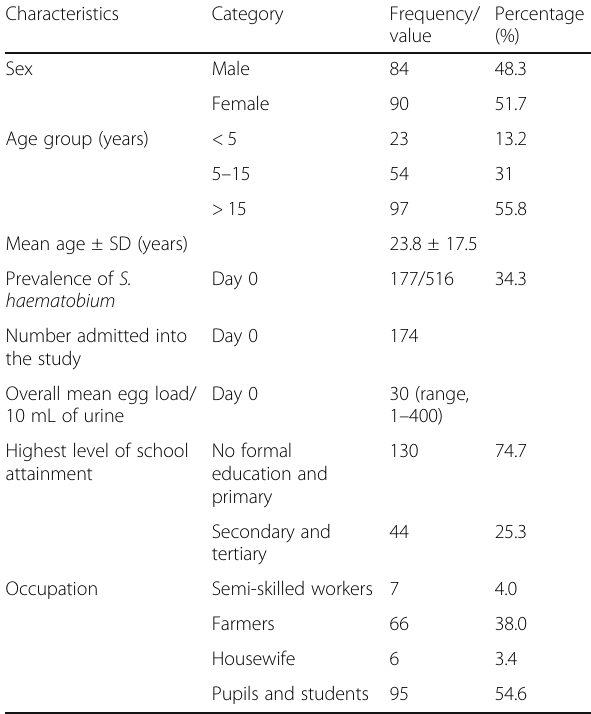
Table 1 Characteristics of participants in the monitoring of praziquantel efficacy on S. haematobium in the Ikata-Likoko area of southwest Cameroon ( n = 174)